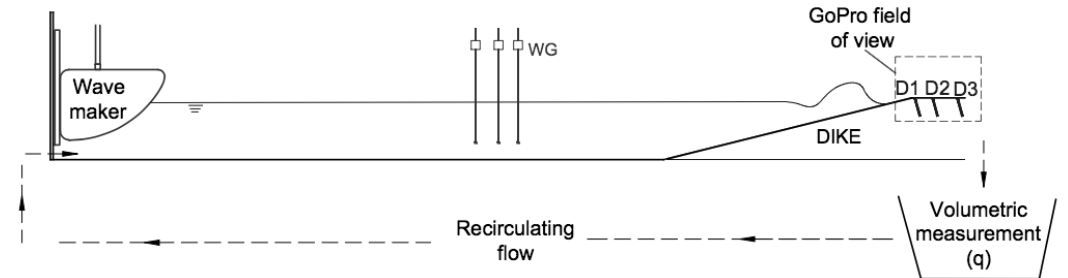
Figure 1. Sketch of the wave flume (Not to Scale) and layout of the used instruments: three WGs at the middle of the channel, three UVP probes along the dike crest (namely D1, D2 and D3), GoPro recording window, tank for q measurement (i.e., overtopping cumulated volume), and recirculation flow system.